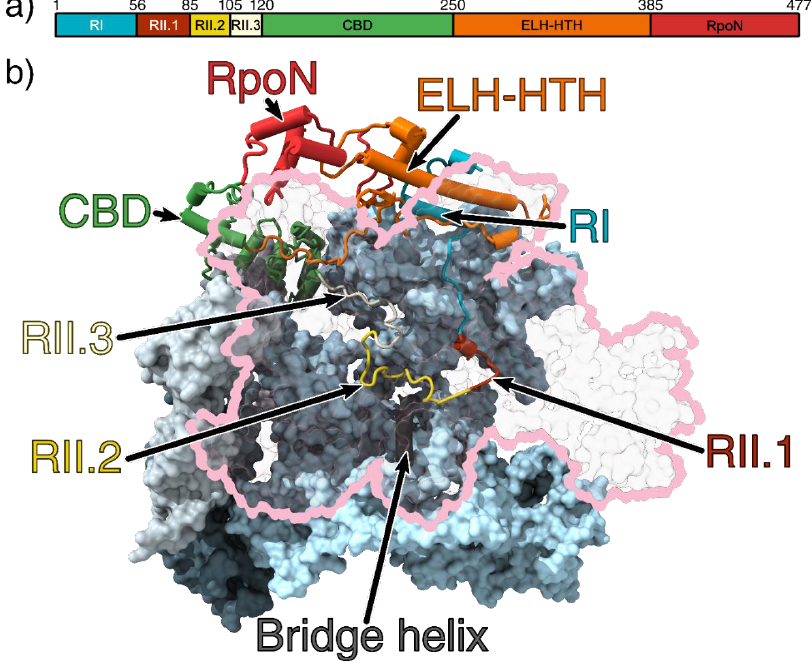
Figure 1. ( a ) Domain organisation of σ 54 . ( b ) The 3.8 Å crystal structure of the RNAP-σ 54 holoenzyme (PDB ID: 5NWT) showing σ 54 inside the RNAP cleft. Region I and an extra-long α-helix followed by a helix-turn-helix (ELH-HTH) sit outside the cleft to form a barrier to block DNA entry, whilst the core-binding domain (CBD) blocks the RNA exit channel. The β subunit is outlined in pink and transparent for clarity [6]. The catalytic site is made up of the β and β’ cleft (pink and light blue, respectively) and are stabilised by the α 1 and α 2 (light and dark grey, respectively) homodimers and ω subunit (obscured by the β’ subunit) [20,21]. Region I (RI) is coloured cyan; ELH-HTH, orange; RpoN, red; CBD, green; Region 2.1 (RII.1), crimson; RII.2, yellow; and RII.3, white. All figures rendered in ChimeraX [22].